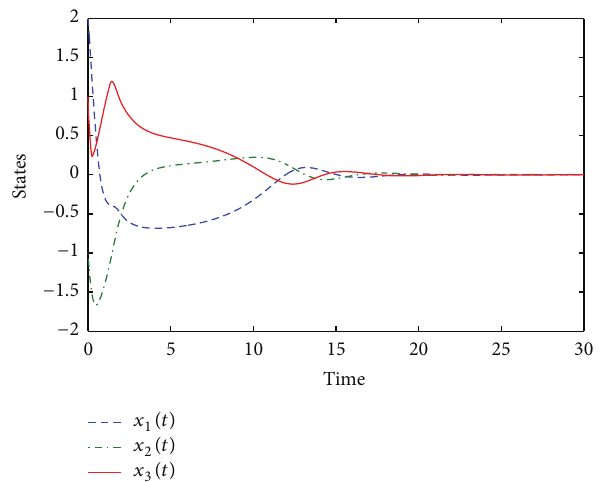
Figure 6: Time response of the state variables with fractional order 𝛼 = 1.04 .